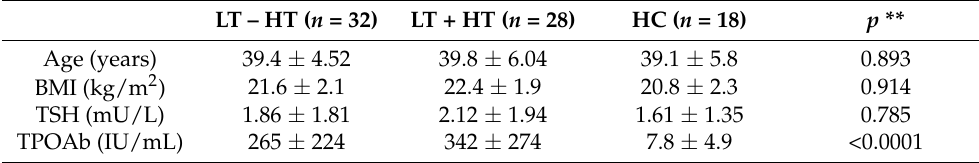
Table 1. Demographic characteristics for all participants (Mean + SD *).